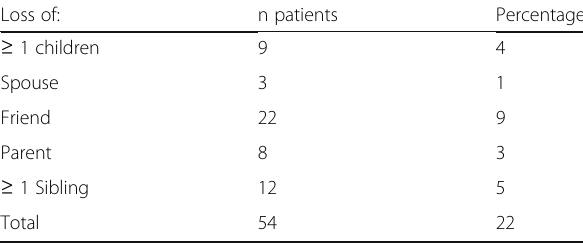
Table 2 Personal losses during the 2014 incursions Loss of: n patients